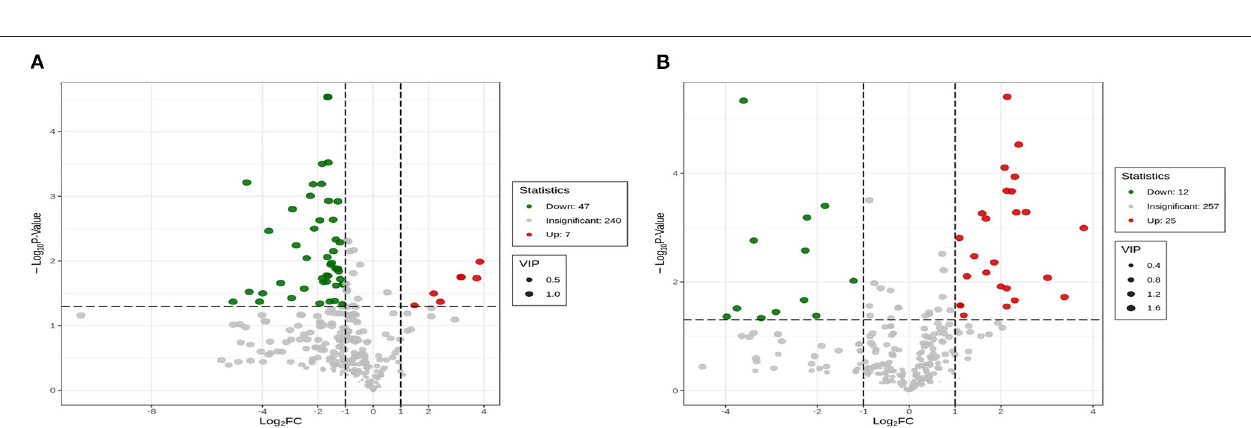
FIGURE 6 | Volcano Plot of SL, SGT, and SBT of GC-MS. (A) SL vs. SBT and (B) SL vs. SGT.